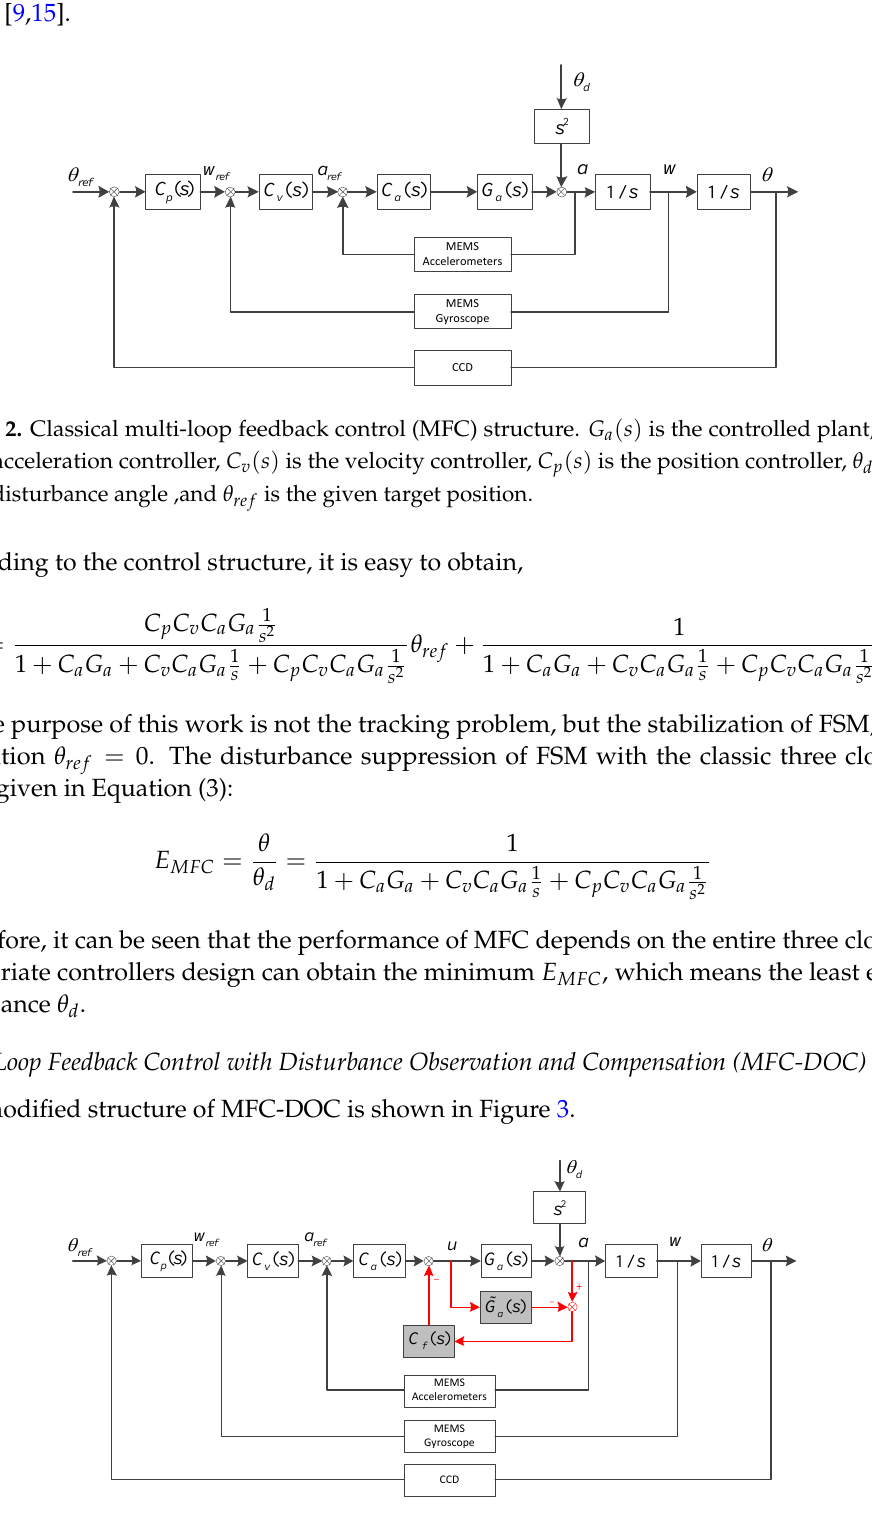
Figure 3. The multi-loop feedback control with disturbance observation and compensation (MFC-DOC) structure. (cid:101) G a ( s ) is the approximate model of the controlled plant, which can be obtained by fitting the measured transfer model, and C f ( s ) is the disturbance compensation